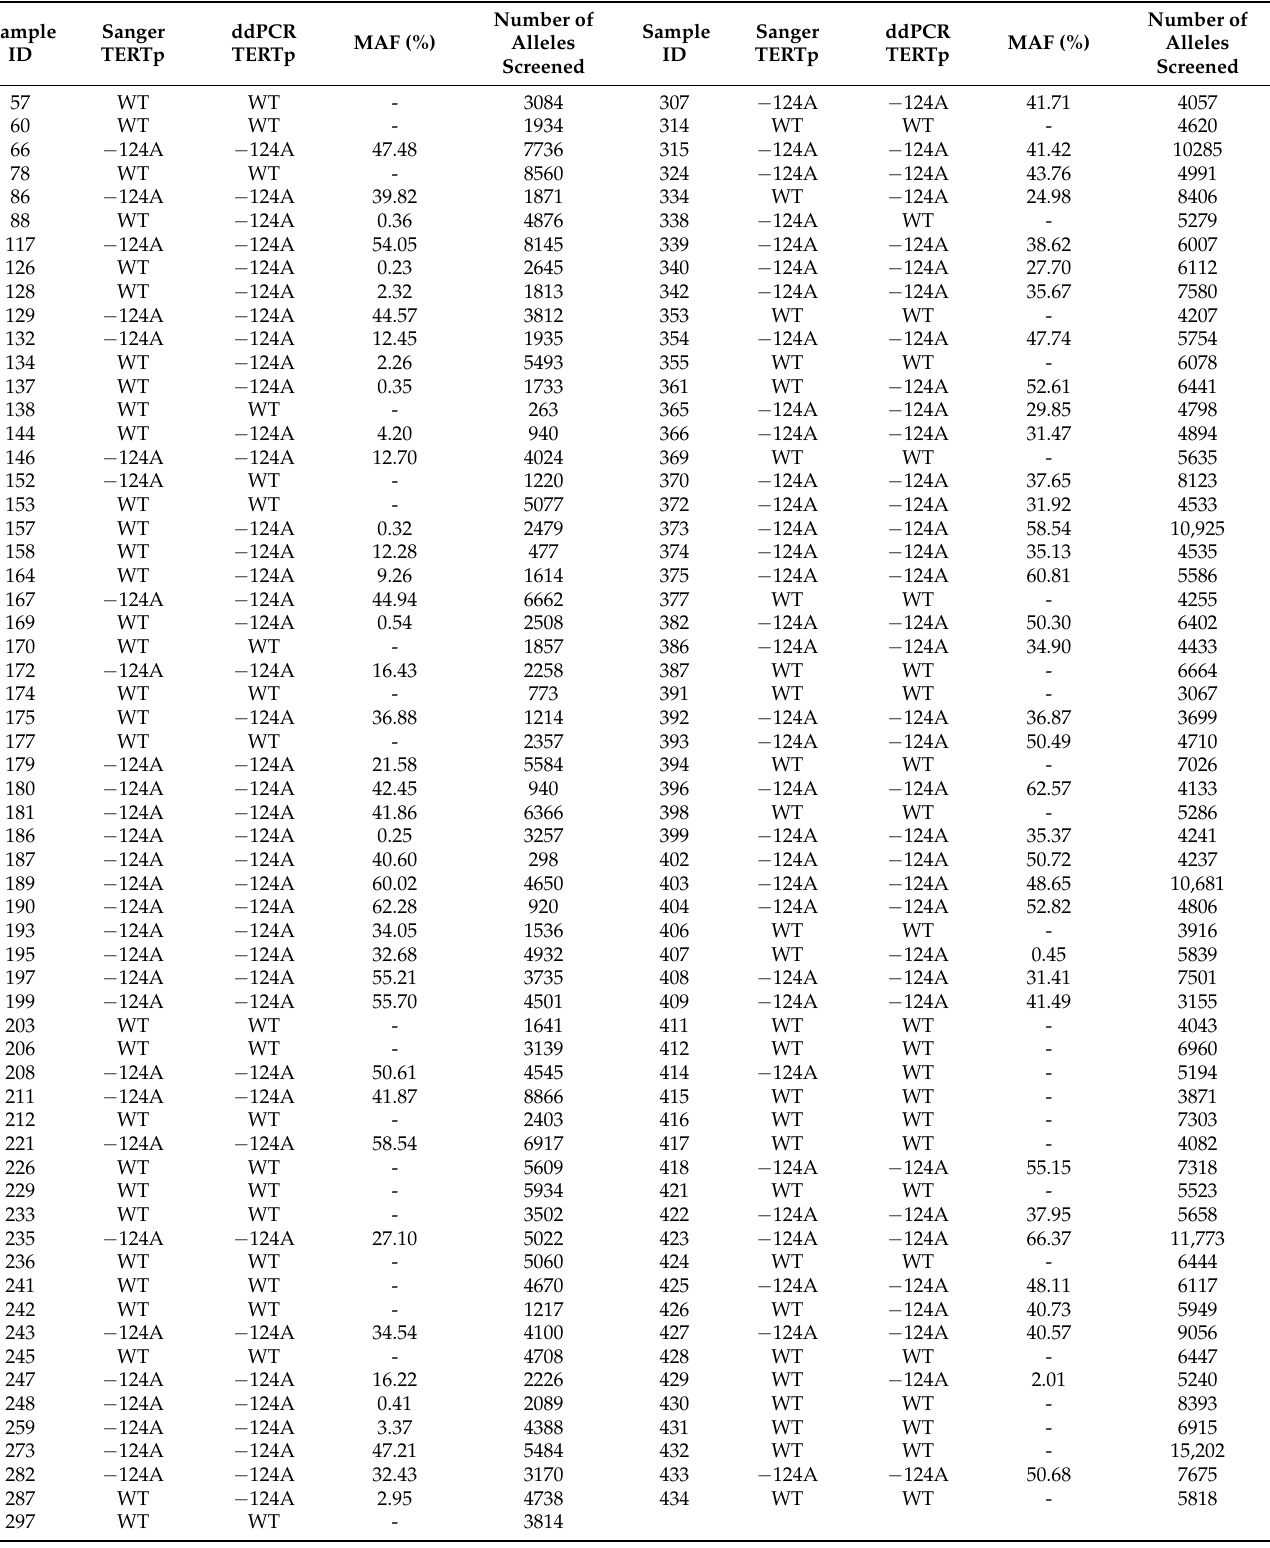
Table 1. Detection of TERTp − 124A mutation by ddPCR and Sanger sequencing in DNA samples extracted from liver cancer